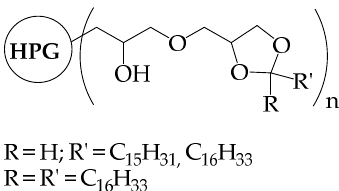
Figure 6. A hydrophilic hyperbranched polyglycerol, whose vicinal hydroxyl groups were partially functionalized as acetals or ketals by reacting with aldehydes or ketons with long alkyl chains. Reproduced with permission from reference [32], Wiley, 2002.